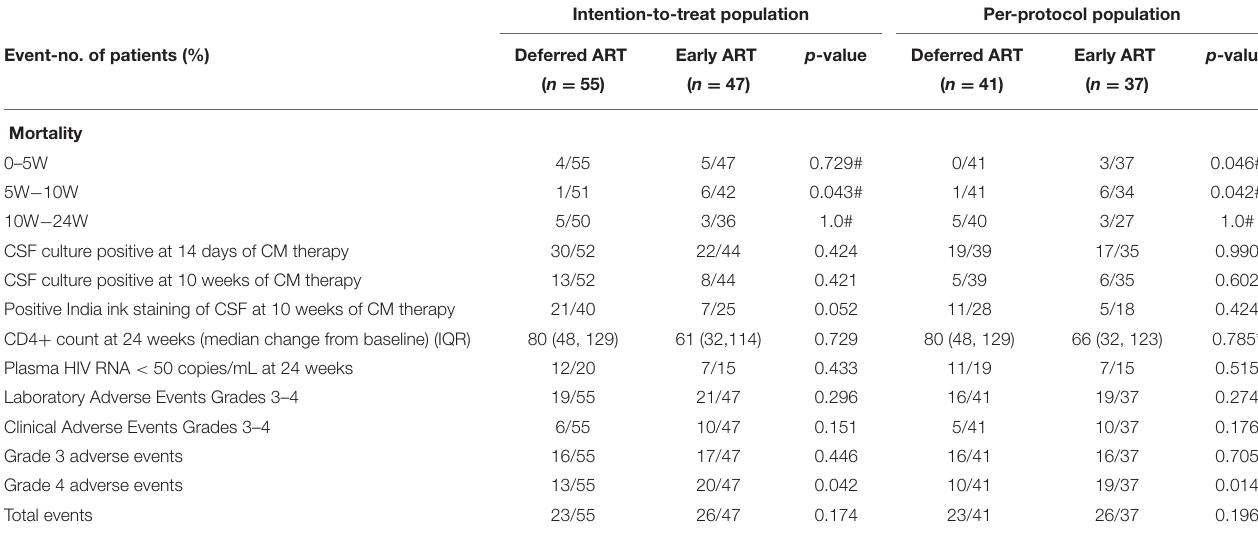
TABLE 2 | Secondary outcomes in the two treatment arms in the intention-to-treat population and in the per-protocol population. Intention-to-treat